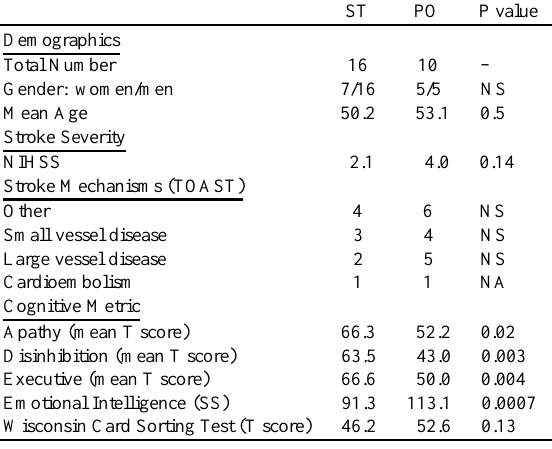
Table 1 Demographics, clinical and cognitive characteristics in the ST